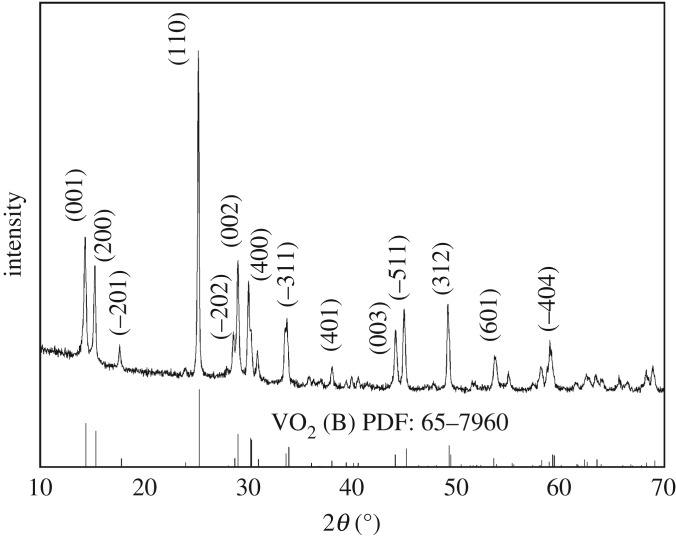
XRD of as-synthesized VO2.